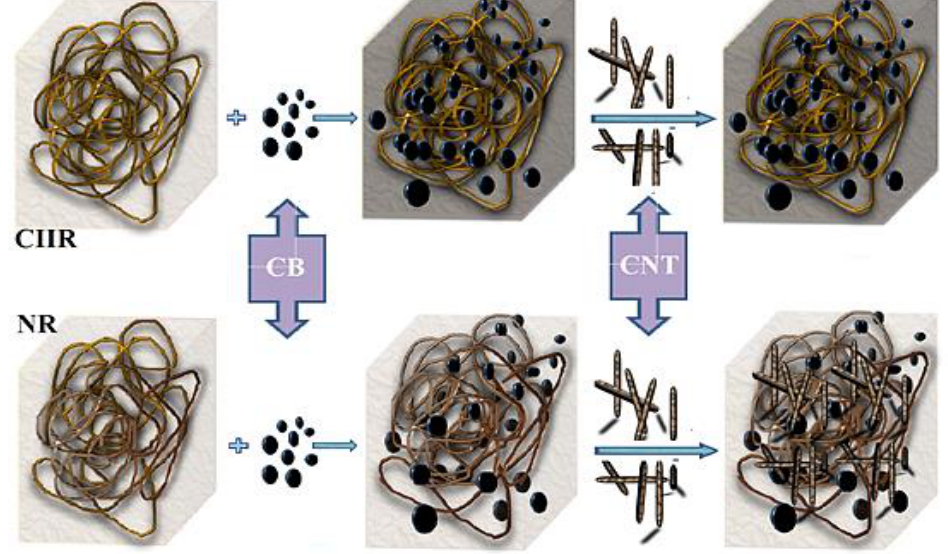
Figure 2. Schematic representation of the interaction between ionic NR/CIIR and CNT-CB.